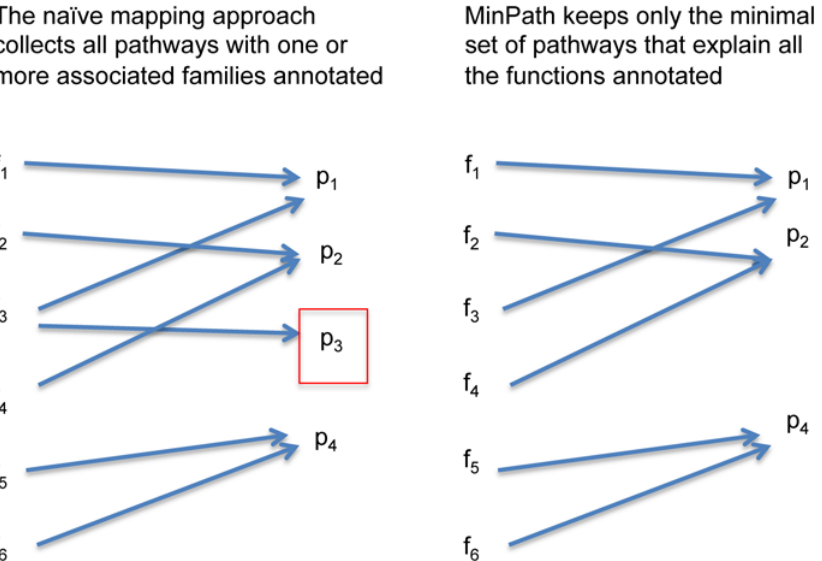
Figure 1. Schematic illustration of the MinPath method. Assume 6 families (or orthologous groups, f 1 , …, f 6 ) are identified from a given sample of genes (e.g., the genes could be from a genome, or sampled from a metagenome). The naı¨ve mapping approach (shown on the left) will lead to a reconstruction with 4 pathways annotated (p 1 , p 2 , p 3 , and p 4 ). Due to the overlapping nature of the biological pathways (see text for more details), pathway p 3 shares function f 3 with pathway p 2 . We claim that only three pathways, p 1 , p 2 , and p 3 are sufficient to explain the existence of the 6 families annotated in the dataset, and a conservative reconstruction of pathways should have only 3 pathways (shown on the right). As we show